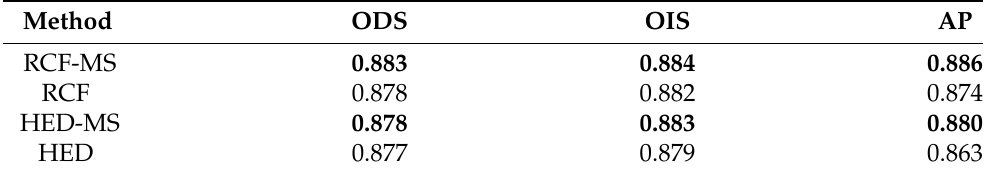
Figure 12. P-R curve of multi-scale edge detection and fusion of image pyramid. Table 4. Comparison of multi-scale edge detection and fusion of image pyramid